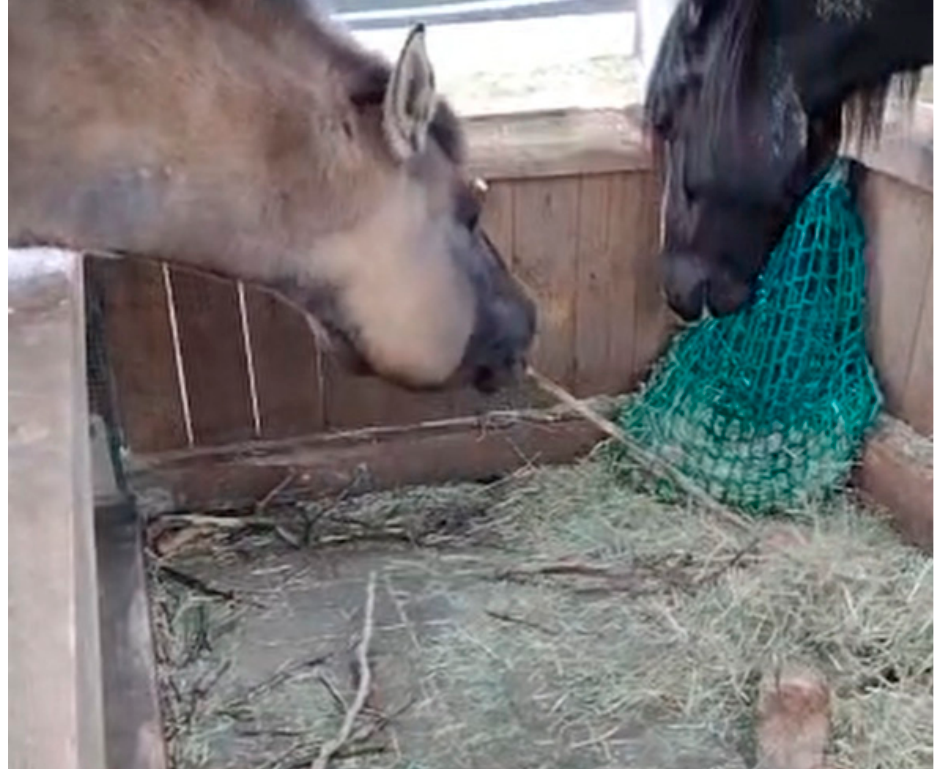
Figure 1. Horse using a stick to scrape hay into reach (Video S1). Contentious cases were excluded from the total data set as described in [2]. The 20 “tool use” cases were rated by three independent observers, one professor, one PhD student and one bachelor’s student in equine science, on whether they were unambiguous. The observers agreed in 100% of the cases (inter-observer agreement: Cohen’s Kappa κ = 1) and found 13 cases to be unambiguous (Figure 1; Tales 1 and S1; Videos S1–S6) and seven ambiguous (Table S1; Video S7). The seven ambiguous cases were excluded from